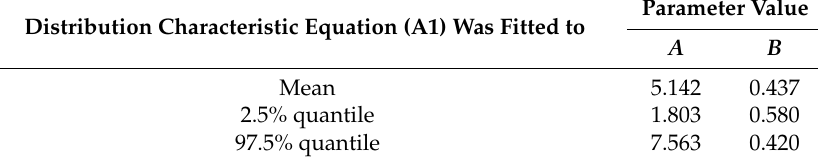
Table A1. Parameter values that result from fitting of Equation (A1) to the distribution of individual tree height–diameter data.